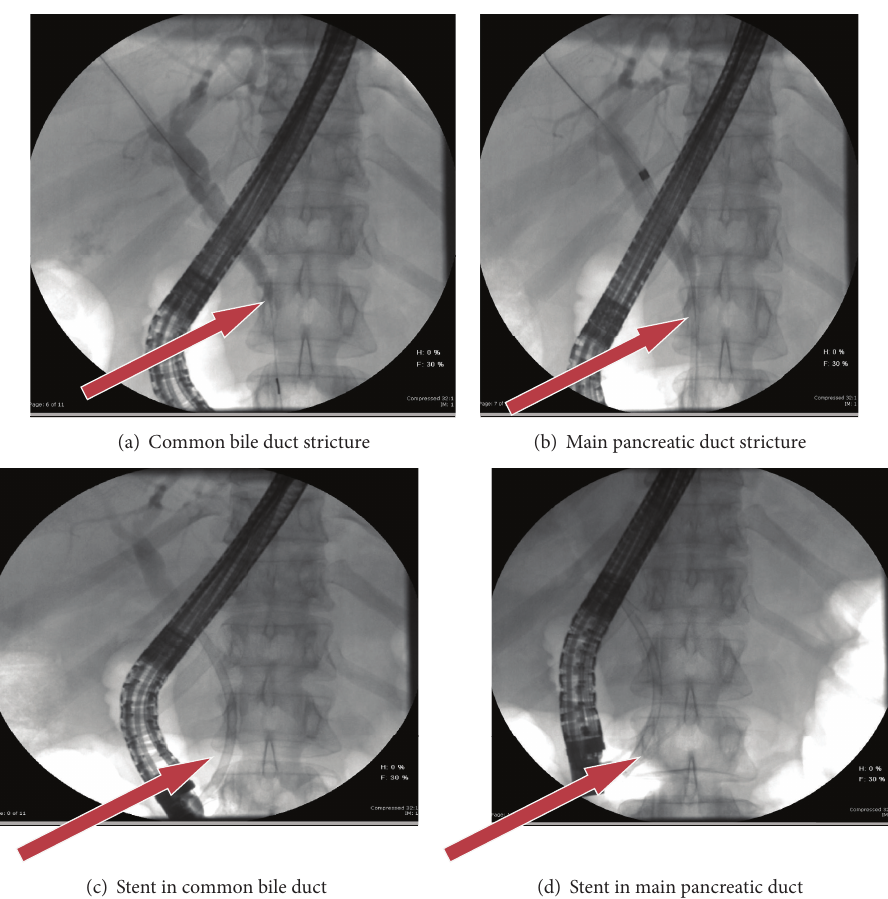
Figure 3: ERCP arrows showing CBD and MPD strictures pre stent insertion (a) and (b); post stent insertion (c) and (d)